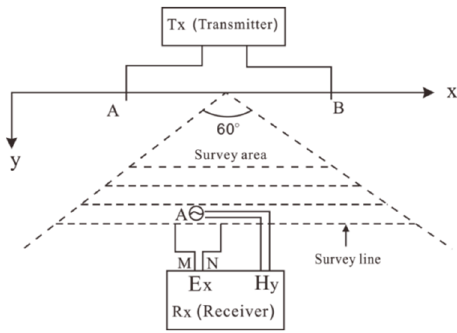
Figure 4. Sketch Plan of the CSAMT-based Measuring Device.